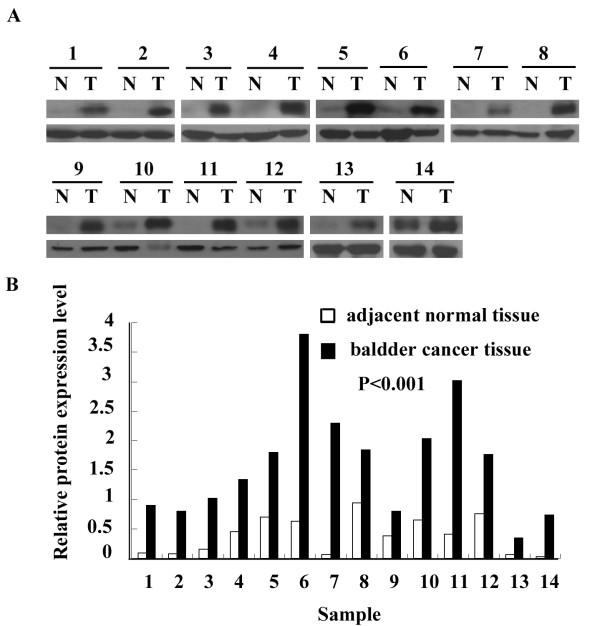
Expression of Bmi-1 protein in paired bladder cancers and the adjacent normal tissues by Western Blot analysis. A: Western Blot analysis in 14 paired bladder cancers and the adjacent normal tissues (upper panel); α-tubulin as the loading control (showed in lower panel). B: The relative expression level of Bmi-1 in comparison to the expression level of α-tubulin.